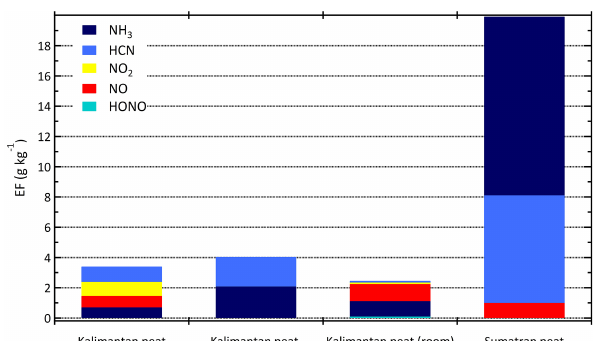
Figure 7. Emission factors (gkg − 1 ) for all nitrogen-containing species measured in current Kalimantan and past Sumatran labo- ratory peat fires (Christian et al., 2003). The Kalimantan peat room burn includes NH 3 , a sticky species; thus the value should be con- sidered a lower limit